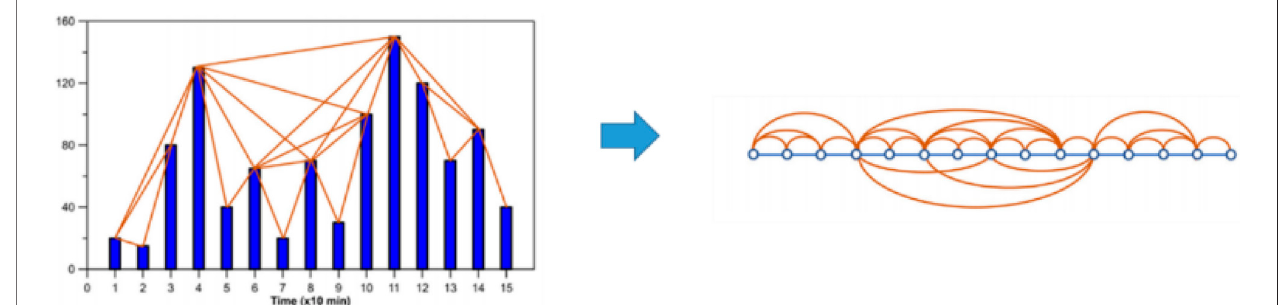
FIGURE 1 | The theory of time series data visualization.